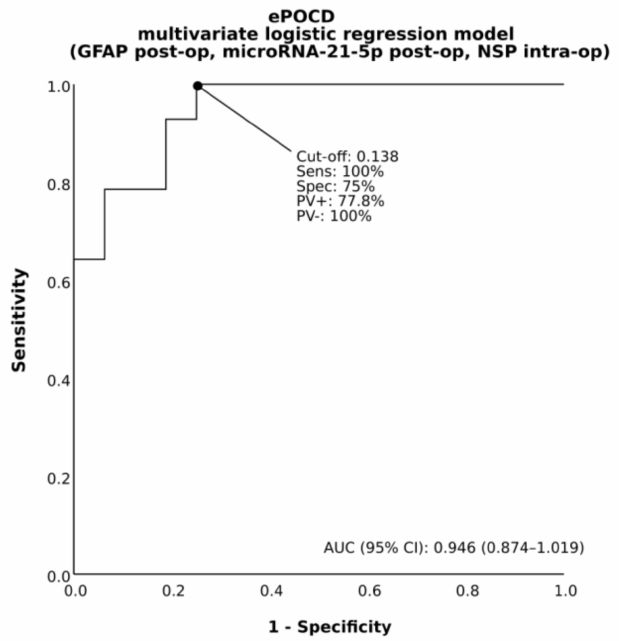
Figure 3. Receiver operating characteristic of a multivariable logistic regression model (incorporating the value of postoperative expression (i.e., 24 h postoperative to end of surgery plasma level ratio) of microRNA-21-5p and glial fibrillary acidic protein [GFAP] as well as an intraoperative expression (i.e., end to start of surgery plasma level ratio) of neuroserpin [NSP]) to predict early postoperative cognitive dysfunction (ePOCD). AUC indicates area under the curve; CI, confidence interval; PV+, positive predictive value; PV-, negative predictive value; Sens, sensitivity; Spec,